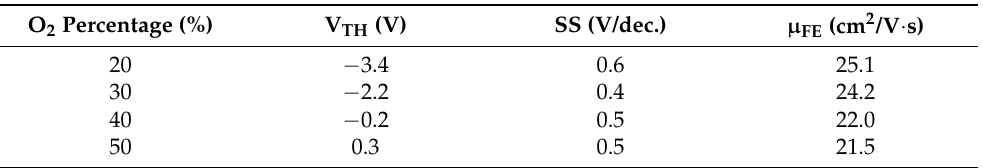
Table 1. Electrical parameters obtained from the IGTO TFTs prepared at the oxygen contents of 20%, 30%, 40%, and 50% in the sputtering ambient.